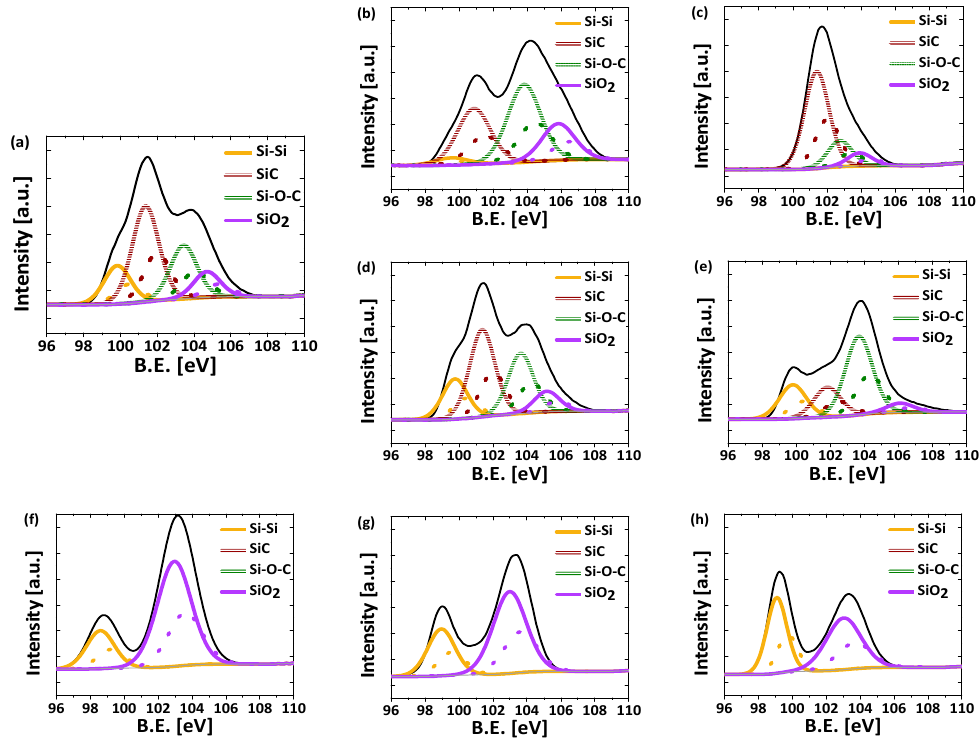
Figure 4. Si species obtained by the deconvolution of Si 2p XPS spectra for ( a ) rHG/85-50, ( b ) rHG/85-50-Mg, ( c ) rHG/50-50, ( d ) rHG/85-5, ( e ) rHG/85-1, ( f ) rSG-50, ( g ) rSG-5 and ( h ) Table 3. Content of Si and SiC determined by XPS analysis, and the percentage of silicon remaining in nonreduced compounds in the materials studied.